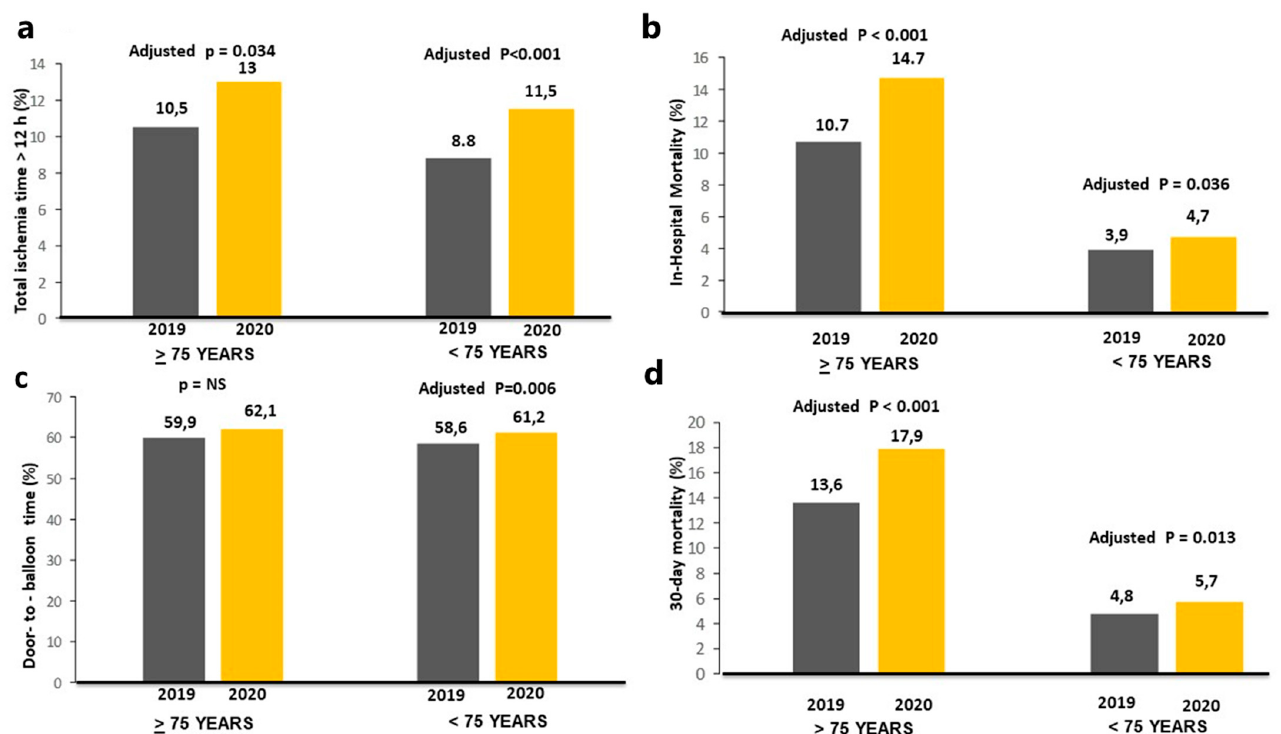
Figure 2. Bar graphs on the left side show the association between the year of intervention with time delays (ischemia time longer than 12 h, ( a ), upper-left graphs; door-to-balloon time longer than 30 min, ( c ), lower-left graphs). Bar graphs on the right side show the association between the year of intervention with in-hospital ( b ), upper-right graphs) and 30-day mortality ( d ), lower-right graphs).